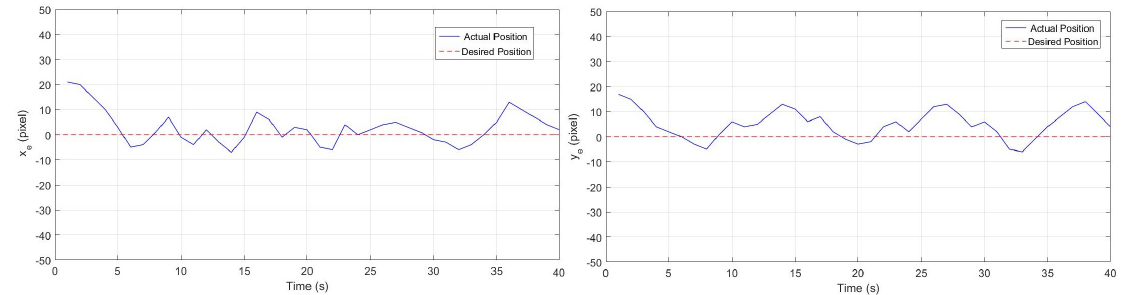
Figure 10. Graph of error state variables, ( left ) x e and ( right ) y e